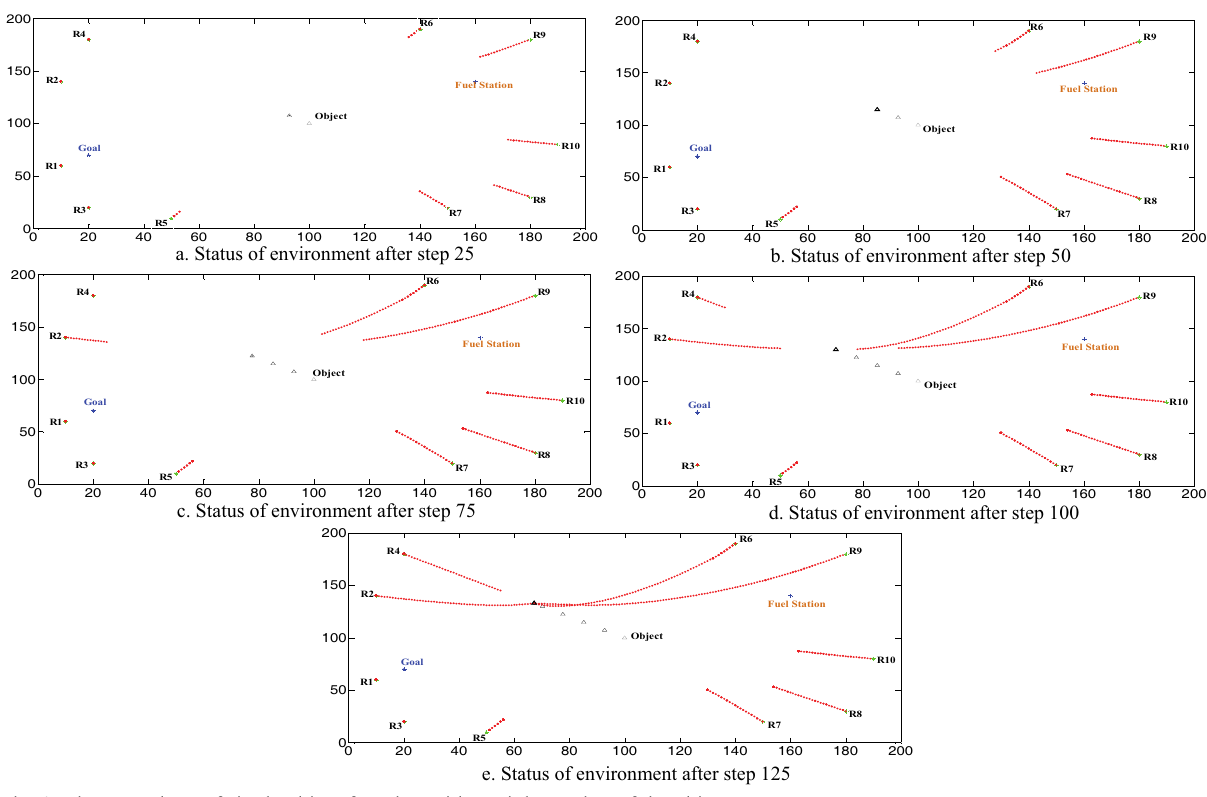
Fig. 9. Five snapshots of single object foraging with straight motion of the